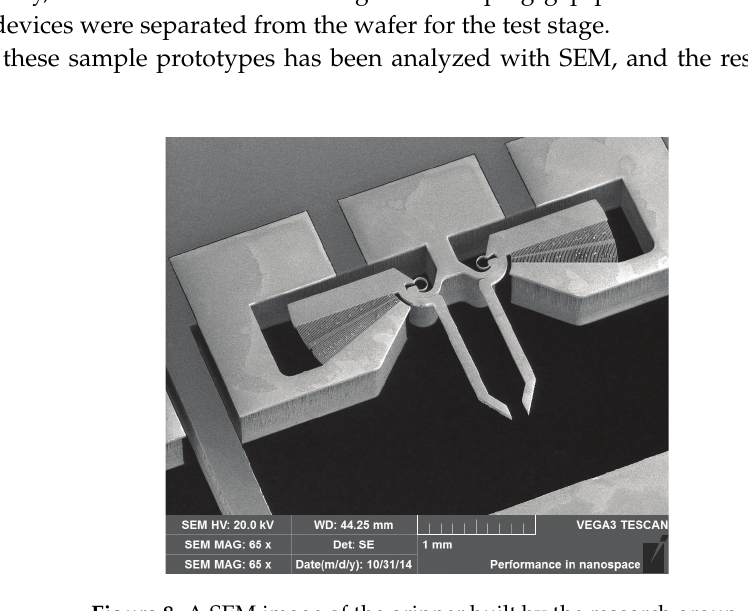
Figure 8. A SEM image of the gripper built by the research